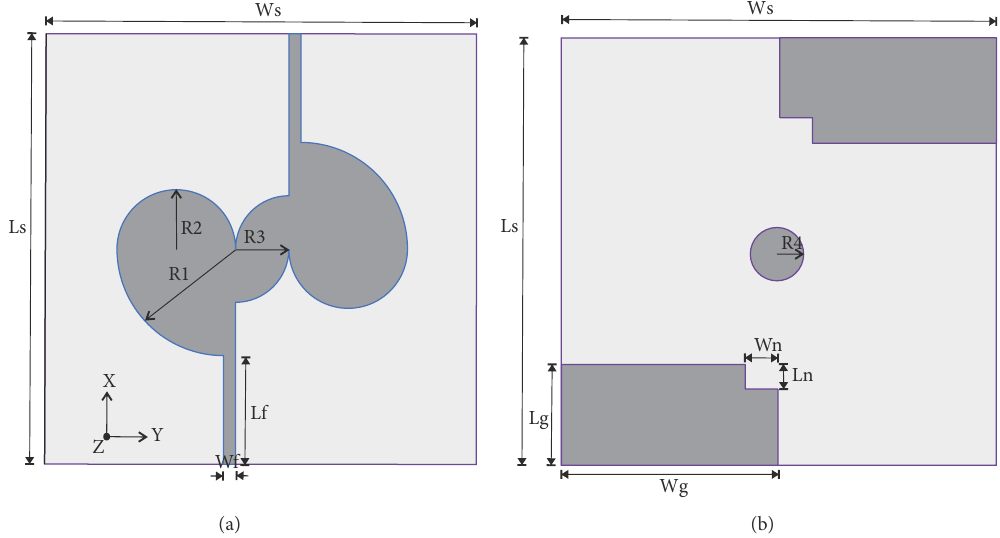
Figure 1: Geometry of the proposed UWB antenna (a) Top view, (b) bottom view of the antenna.